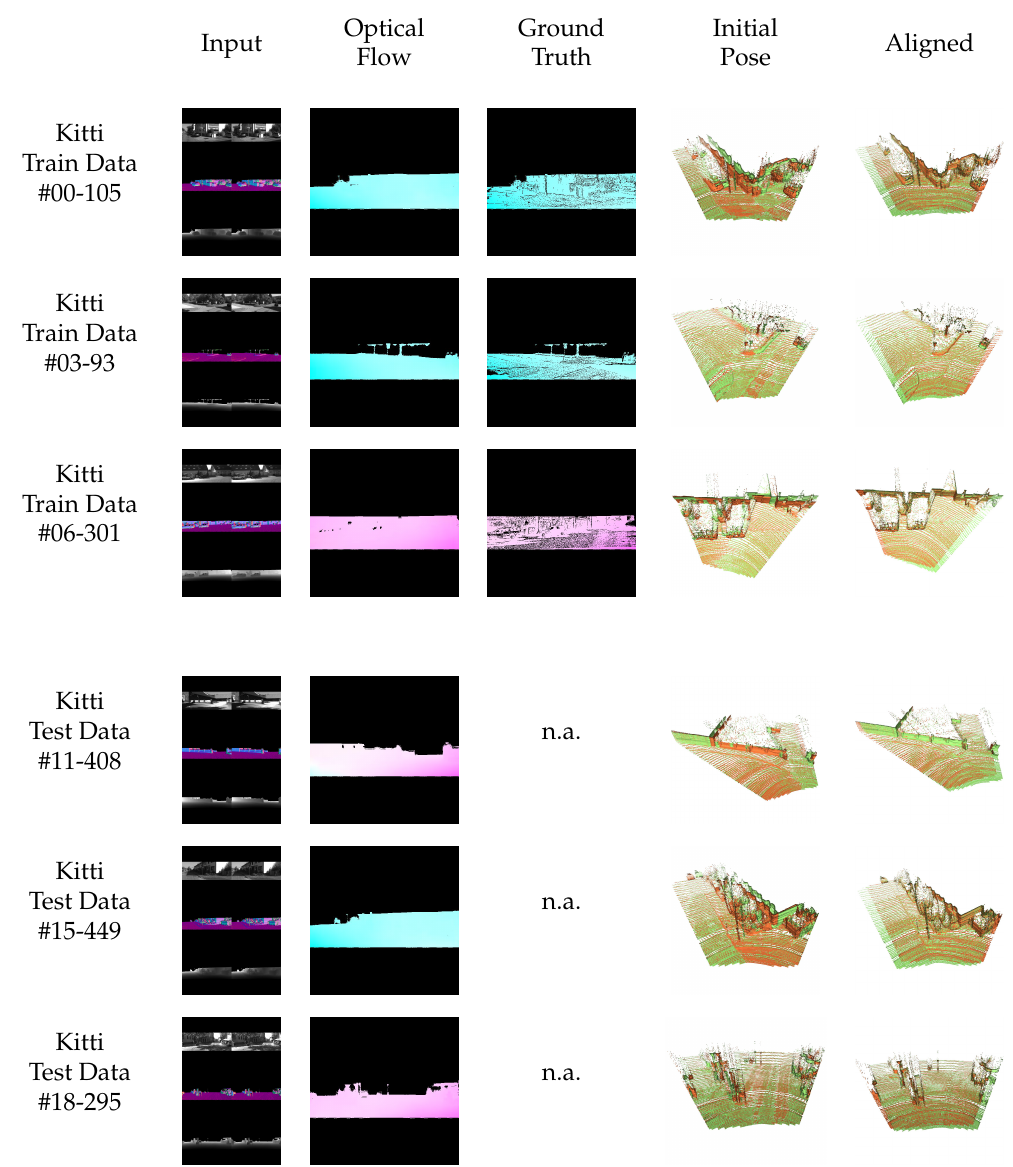
Figure 15. Qualitative results of the proposed method on training and test data of the Kitti Odometry dataset. The method also works on this kind of scenario with less rotations and less shading changes than in the mainly investigated case, but also handles noise resulting from the lidar depth measurement in the Kitti data. The network generalizes well from known training to unknown test